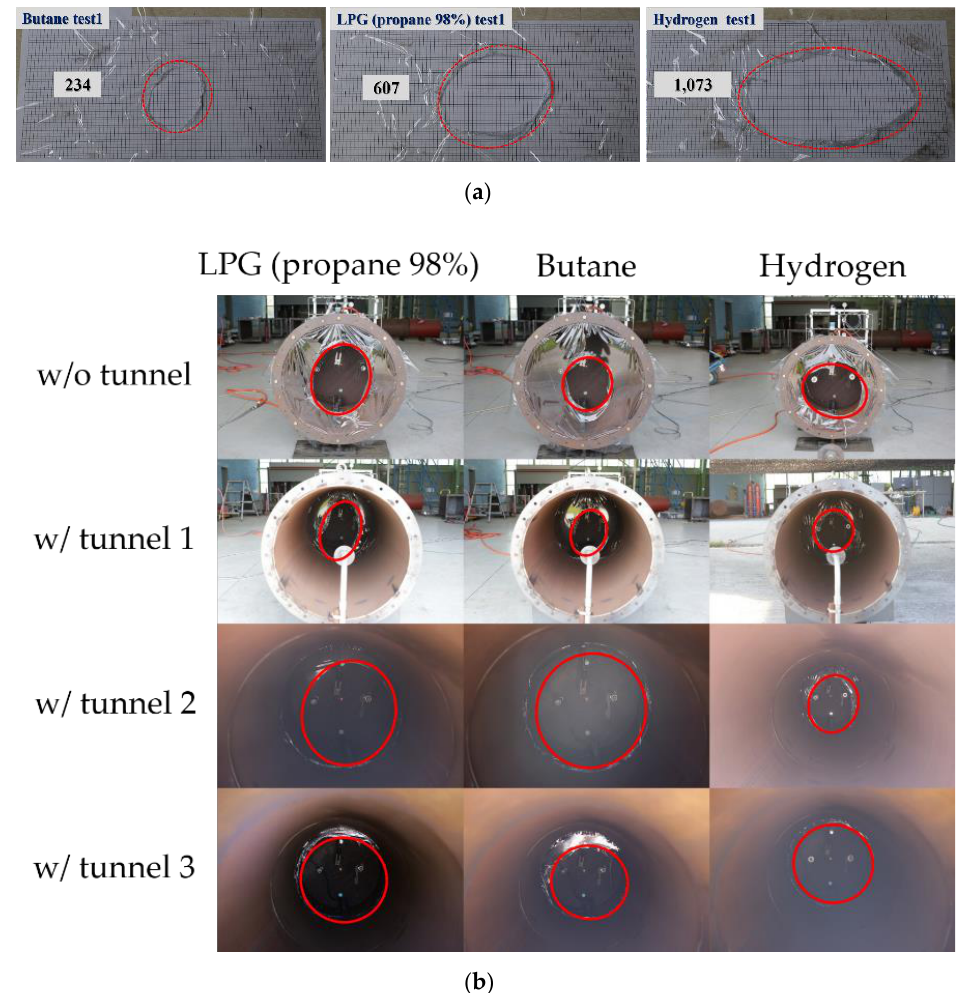
Figure 13. Plastic sheet rupture shapes during the explosion test with and without tunnels; ( a ) Plastic sheet rupture shapes without tunnels, ( b ) Plastic sheet rupture shape with tunnels. Table 3. Plastic sheet rupture shape areas for the cylinder-type chamber without